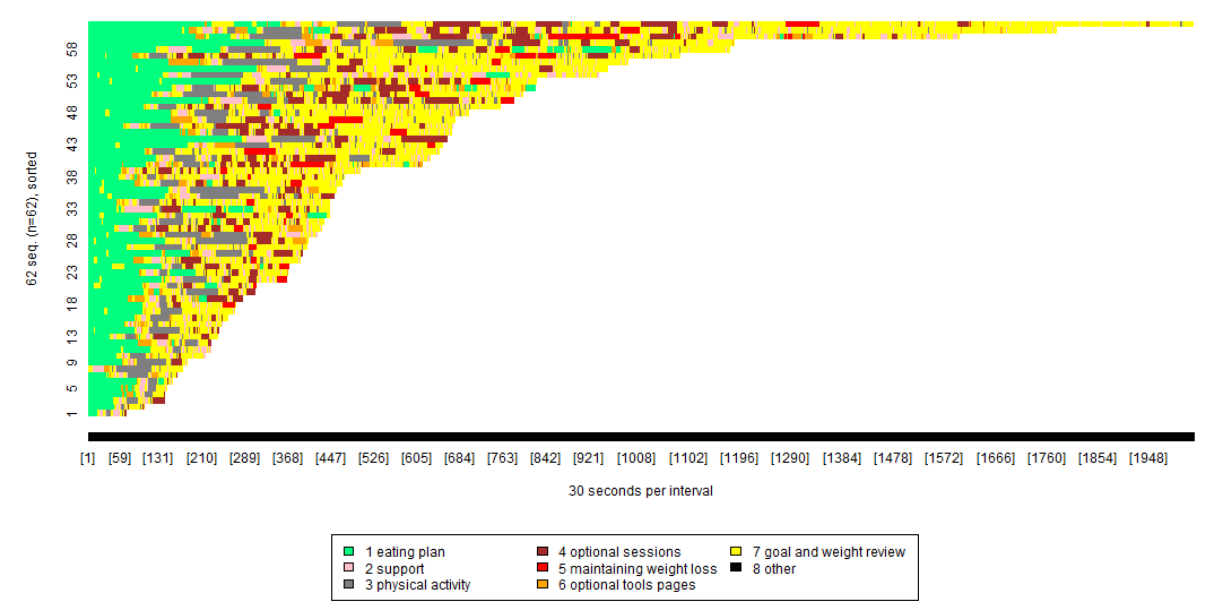
Figure 3. Visualization of POWeR usage by participants who used the optional